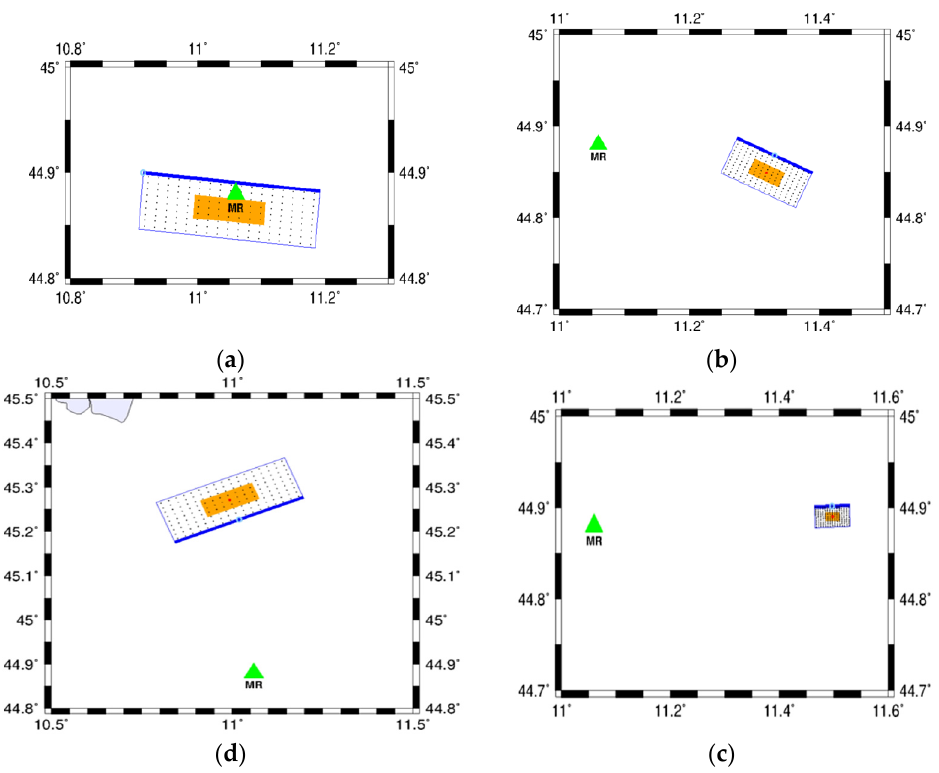
Figure 4. The investigated source-site configurations; ( a ) MIR: M w = 6.0, edi = 1.9 km; ( b ) FE: M w = 6.1, edi = 20.7 km; ( d ) VR: M w = 6.7, edi = 43.8 km; ( c ) FR: M w = 5.5, edi = 34.6 km.